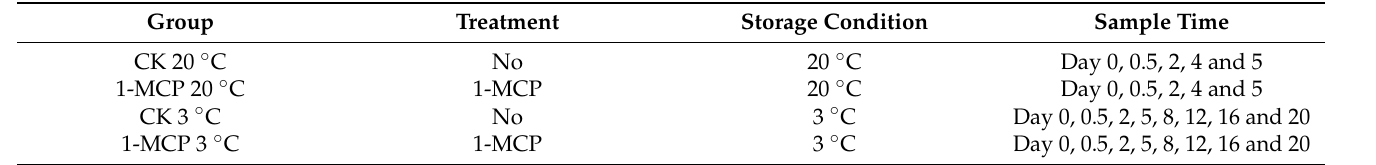
Table 1. Treatments and storage conditions of chive vegetables in four groups. Group Treatment Storage